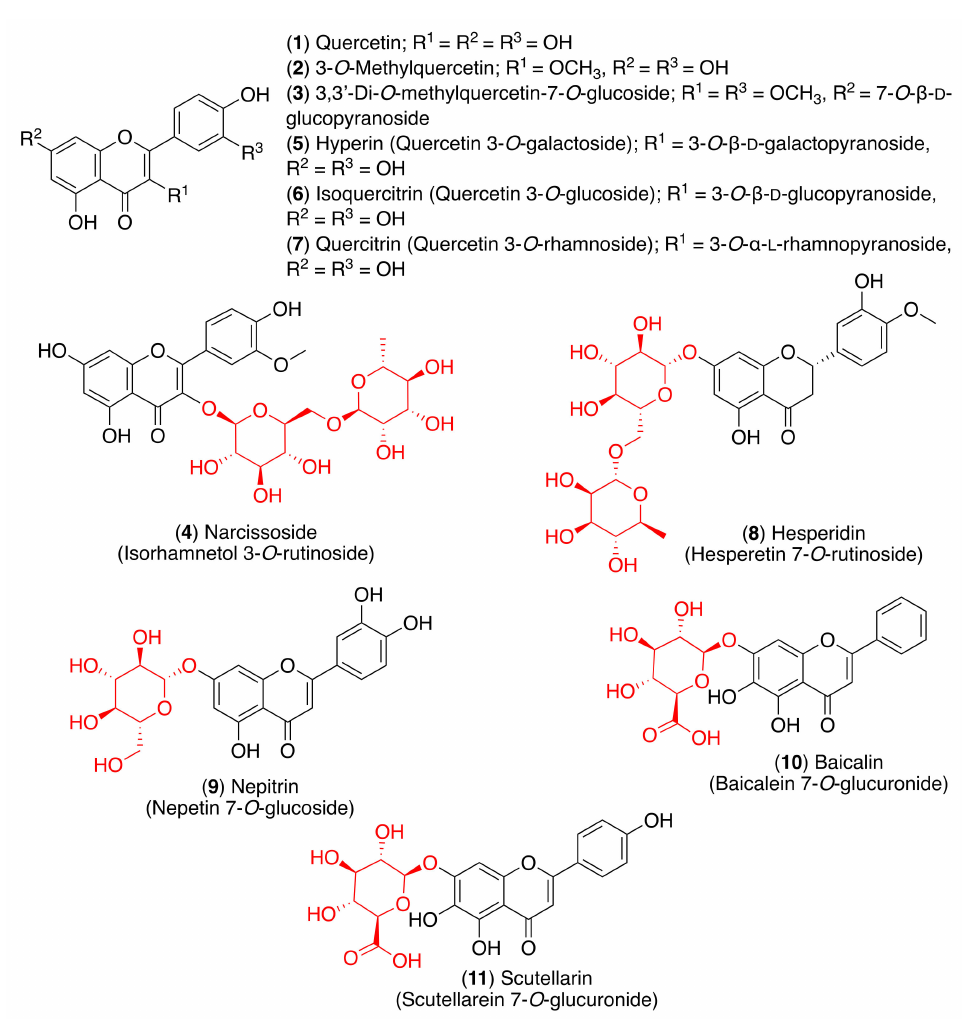
Figure 4. Anti-inflammatory and antioxidant glycosyl